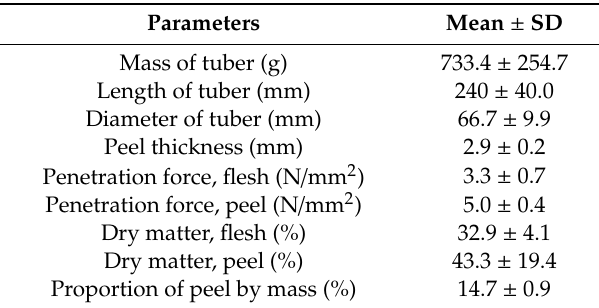
Table 2. Characteristics of cassava tubers (n =